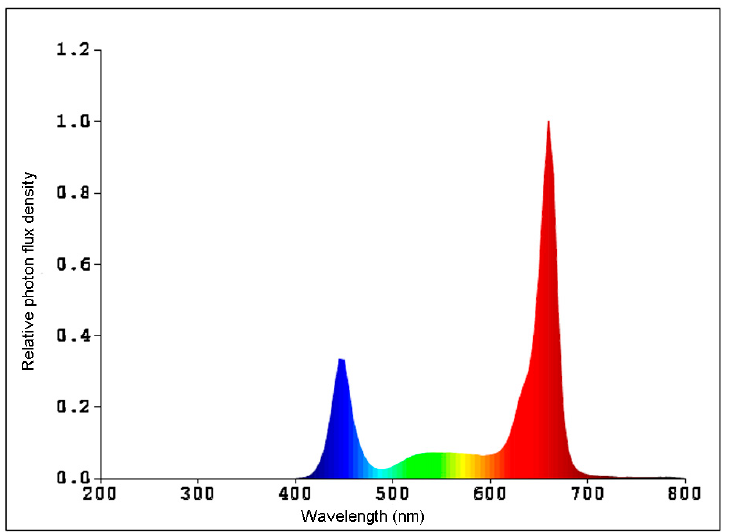
Figure 2. The relative spectral photon flux of AEpic LED-growth lamps in Room 1 of the blueberry plant factory. The wavelengths of light sources were measured with a spectrometer (PMS-2000 v1.01, Everfine corporation, Hangzhou, China).